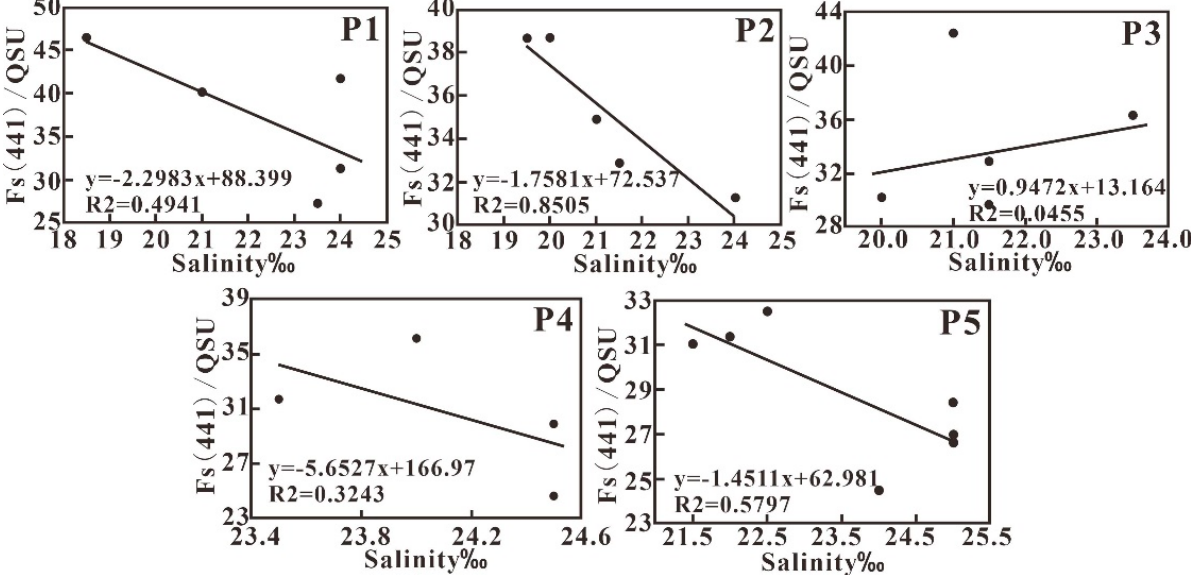
Figure 11. Variations in Fs (441) with salinity along the five transects.